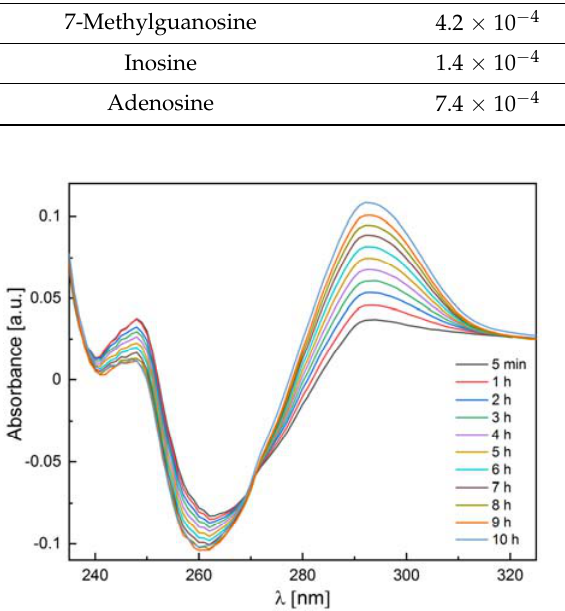
Table 3. Comparison of the phosphorolytic activity of the 6Ala PNP mutant obtained during prolonged scanning kinetic experiment, and the WT PNP activity; 50 mM phosphate buffer, pH 7.0, 25 °C.